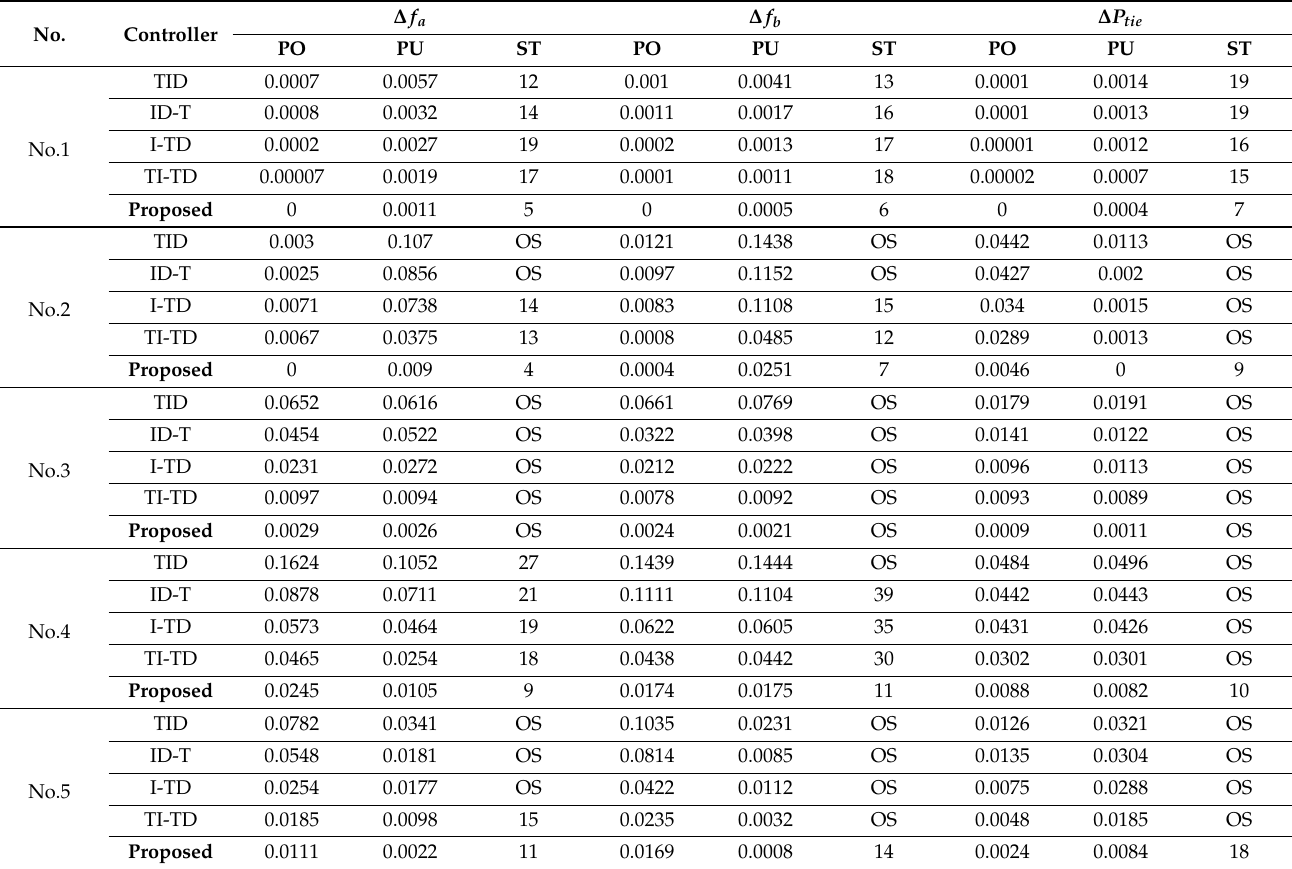
Table 10. Performance comparisons of the tested